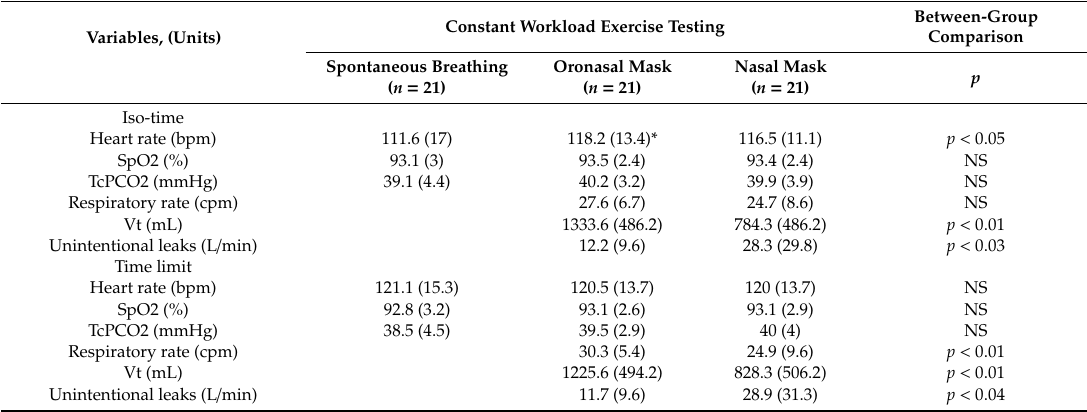
Table 3. E ff ects of non-invasive ventilation on cardiopulmonary outcome at iso-time and time limit. Variables,